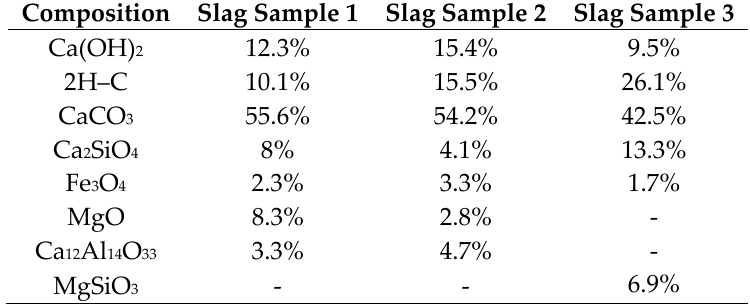
Table 1. Quantification in percentage of slags composition using the technique of X-ray diffraction.